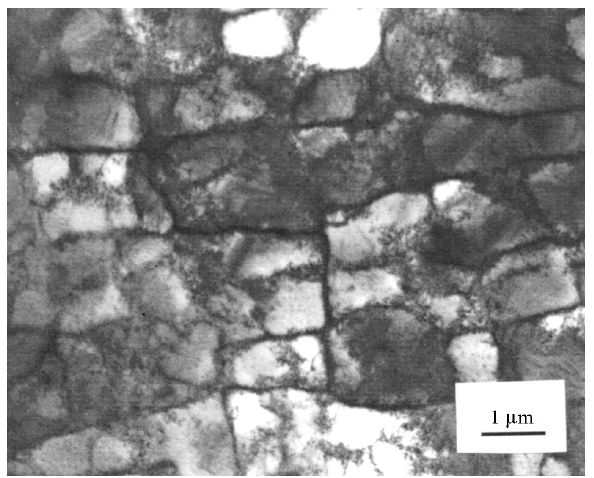
Figure 8. TEM observation of dislocations structure of a specimen drawn in one pass, 8° and 20%, and cyclically